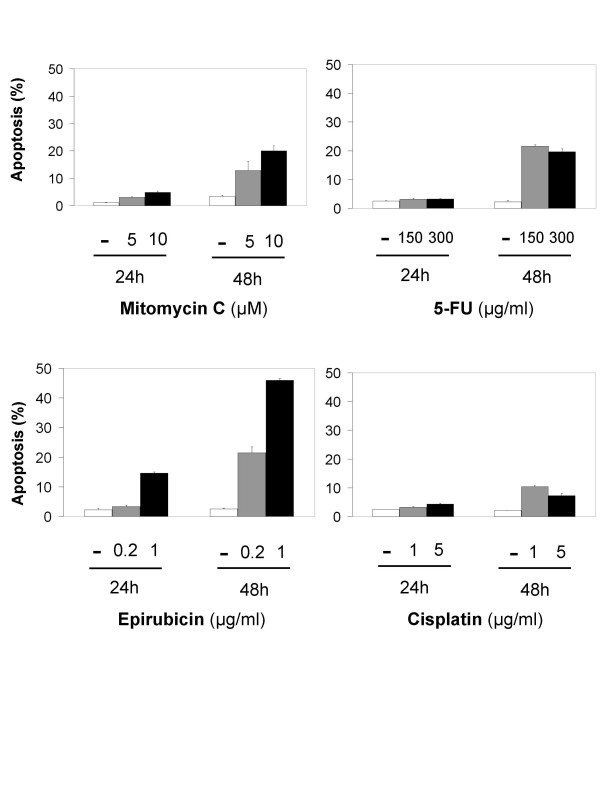
Sensitivity of Huh7 cells towards chemotherapeutic drug-induced apoptosis. Huh7 cells were treated with 5-FU, mitomycin C, epirubicin, or cisplatin for 24 h and 48 h, respectively (concentration as indicated). Cells were then harvested and analyzed for apoptosis induction by flow cytometry according to the method of Nicoletti et al. [29]. Assays were performed in triplicates and are representative for three independent experiments. Values are means + SD.